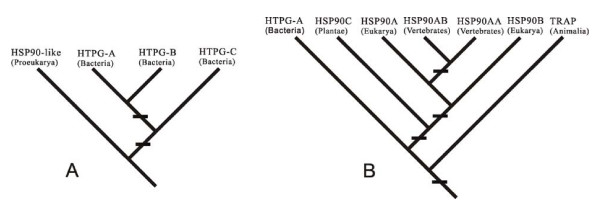
Schematic diagram representing the evolution of proeukaryotic (A) and eukaryotic (B) HSP90 family of genes. The filled bars indicate gene duplication events. A) We propose that HSP90-like genes in Bacteria and Archaea are basal to HTPG genes that only exist in Bacteria. HTPG genes underwent two gene duplication events that gave rise to three groups (Group A, B and C). B) Eukaryotic members were derived from HTPG Group A, and evolved into four subfamilies TRAP (mitochondrial), HSP90A (cytosolic), HSP90B (ER) and HSP90C (chloroplast) throughout three gene duplication events. One additional gene duplication event led to the division of HSP90A into HSP90AA and HSP90AB in vertebrates. The organismal groups in parenthesis indicate where these HSP90 gene copies are found.